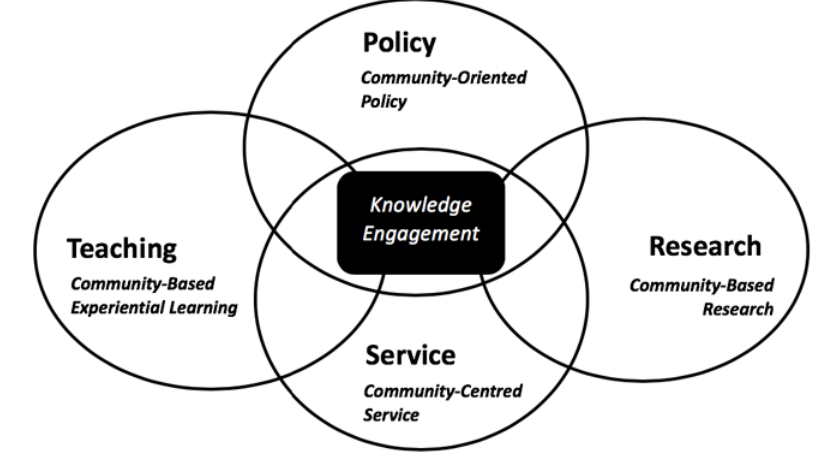
Proposed model for knowledge engagement with newcomer